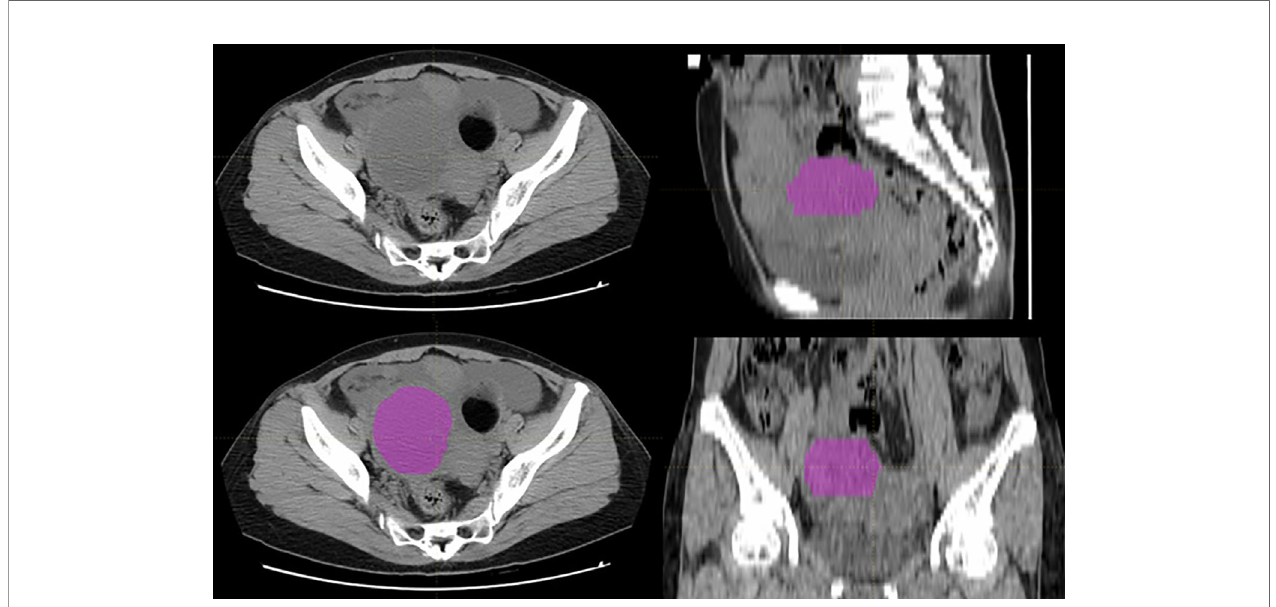
FIGURE 2 | A typical ovarian tumor segmentation on CT images.